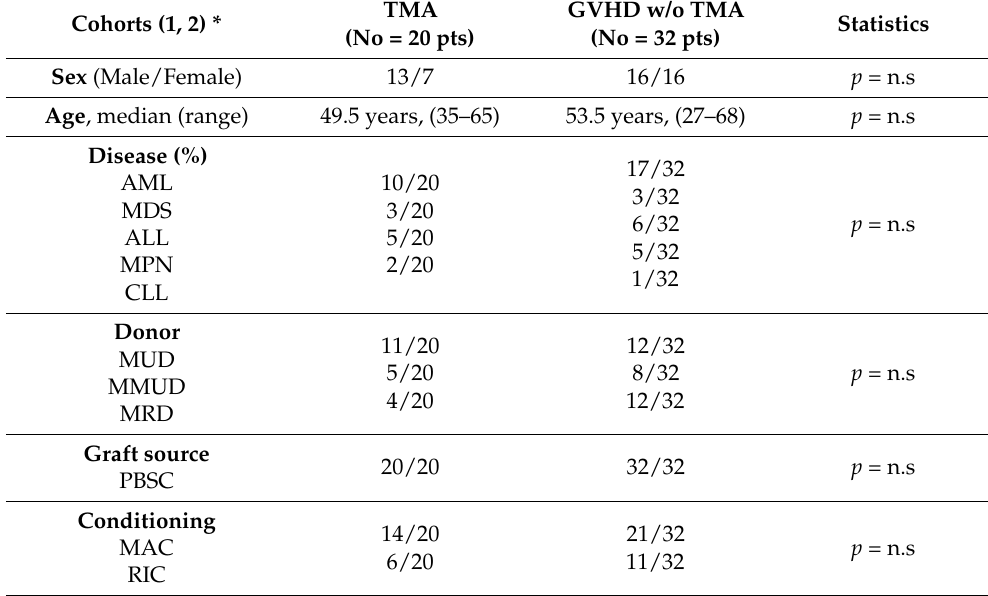
Table 1. Patient